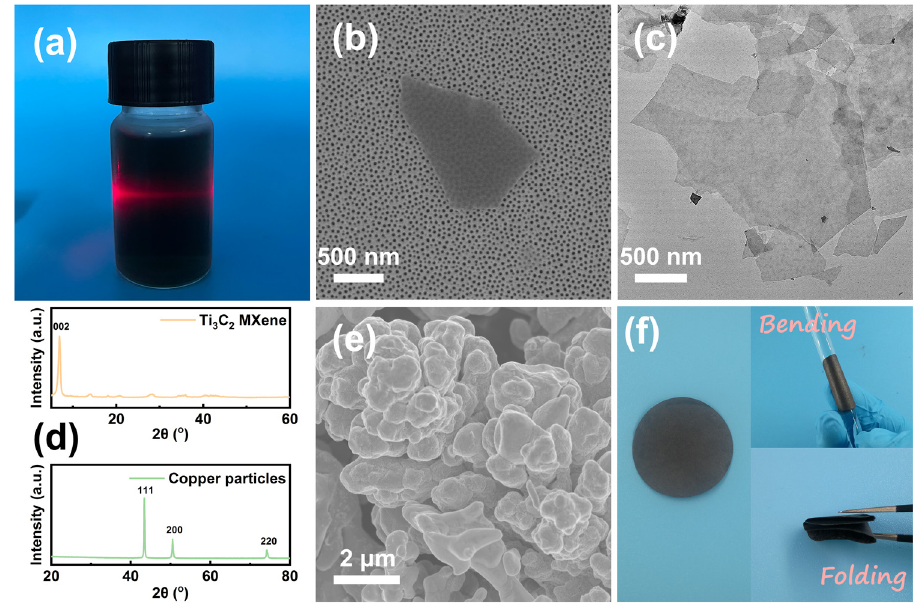
Figure 2: ( a ) Digital picture of Tyndall phenomenon of MXene colloidal solution. ( b ) SEM and ( c ) TEM images of MXene. ( d ) XRD curves of MXene and copper powders. ( e ) SEM image of copper powders in 1 μ m diameter. ( f ) Digital pictures of the MXene/CU/CNF fi lm and bending and folding abilities of the composite fi